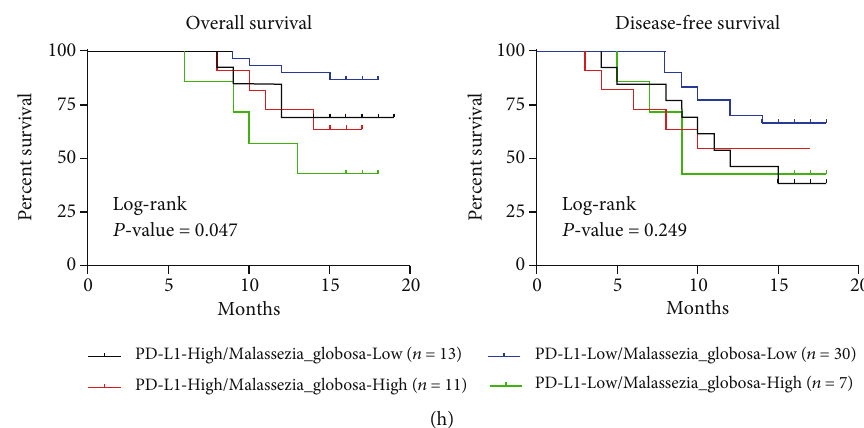
Figure 3: Malassezia globosa was a PD-L1 expression-associated gastric fungus. (a) The distribution of Malassezia. (b and c) The species of Malassezia in the PD-L1-High and PD-L1-Low group. (d) Constituent ratio analysis. (e) The OTU abundance of Malassezia globosa, Malassezia restricta , and Malassezia furfur between the two groups. (f) The high abundance group and low abundance group based on the OTU abundance of Malassezia restricta (cuto ff value = 1238 ), Malassezia globosa (cuto ff value = 140 ) and Malassezia furfur ( cutoff value = 3 ). (g) Survival analysis in the di ff erent subgroups of Malassezia restricta and PD-L1 expression. (h) The OS and DFS time in the di ff erent subgroups of Malassezia globosa and PD-L1